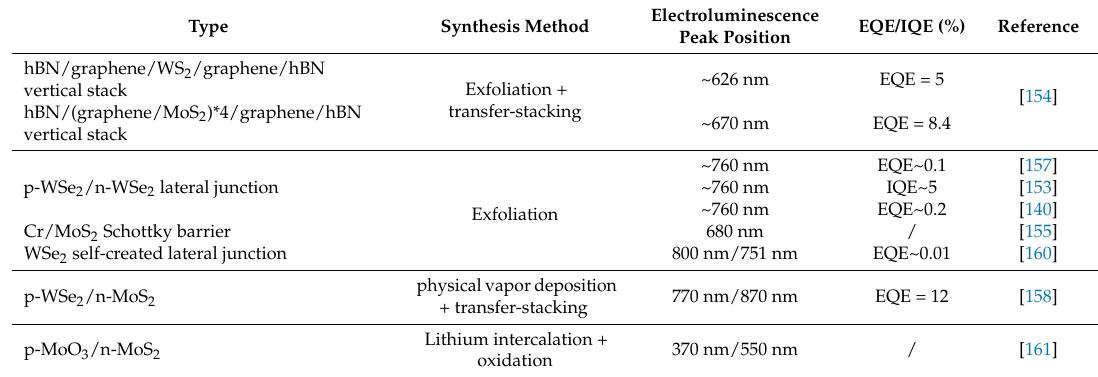
Table 3. Performance of 2D light emission